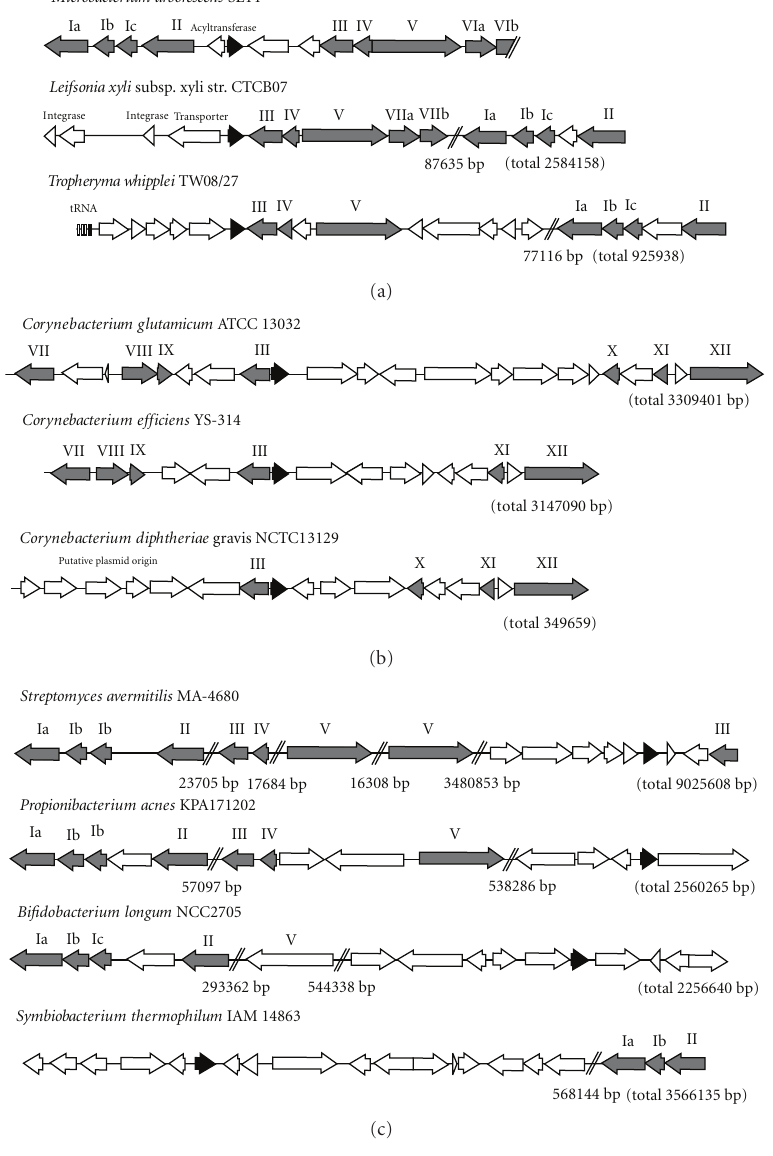
Figure 4: Genomic syntenies on Actinobacterial genomes surrounding the dps- like genes. The genomic sequences have been arbitrarily arranged so that all dps-like genes are transcribed to the right-hand side. Genome sizes were shown in brackets. (a) Alignment of the genomic segments of M. arborescens SE14, L. xyli, and T. whipplei . (b) Alignment of the genomic sequences of three Corynebacterium species. (c) Alignment of the genome of some other Actinobacteria. Regions without interesting gene were omitted and denoted as double slashes with the number of omitted bases showing underneath. The dps-like genes are depicted as black; other conserved genes are in gray labelled with roman numbers: Ia, ATP-dependent Clp protease ATPase; Ib, ATP-dependent Clp protease proteolytic subunits 2; Ic, ATP-dependent Clp protease proteolytic subunit 1; II, FKBP-type peptidyl-prolyl isomerase; III, formamidopyrimidine–DNA glycosylase; IV, ribose 5-phosphate isomerase; V, aminopeptidase N; VIa, ABC transporter ATPase; VIb, ABC transporter membrane component; VII, Malic enzyme; VIII, Zinc- binding dehydrogenases; IX, Methylated DNA-protein cysteine methyltransferase; X, Putative integral membrane protein; XI, MarR family transcriptional regulators; XII, Penicillin-binding